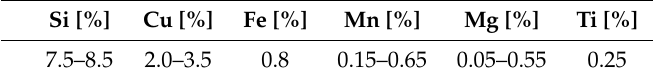
Table 1. Nominal chemical composition of the investigated cast material.